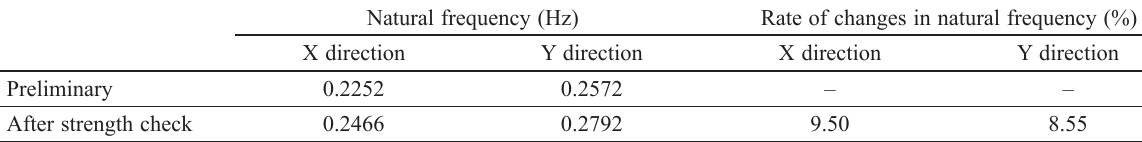
Table 3. Changes in the natural frequencies of the example by the resizing method